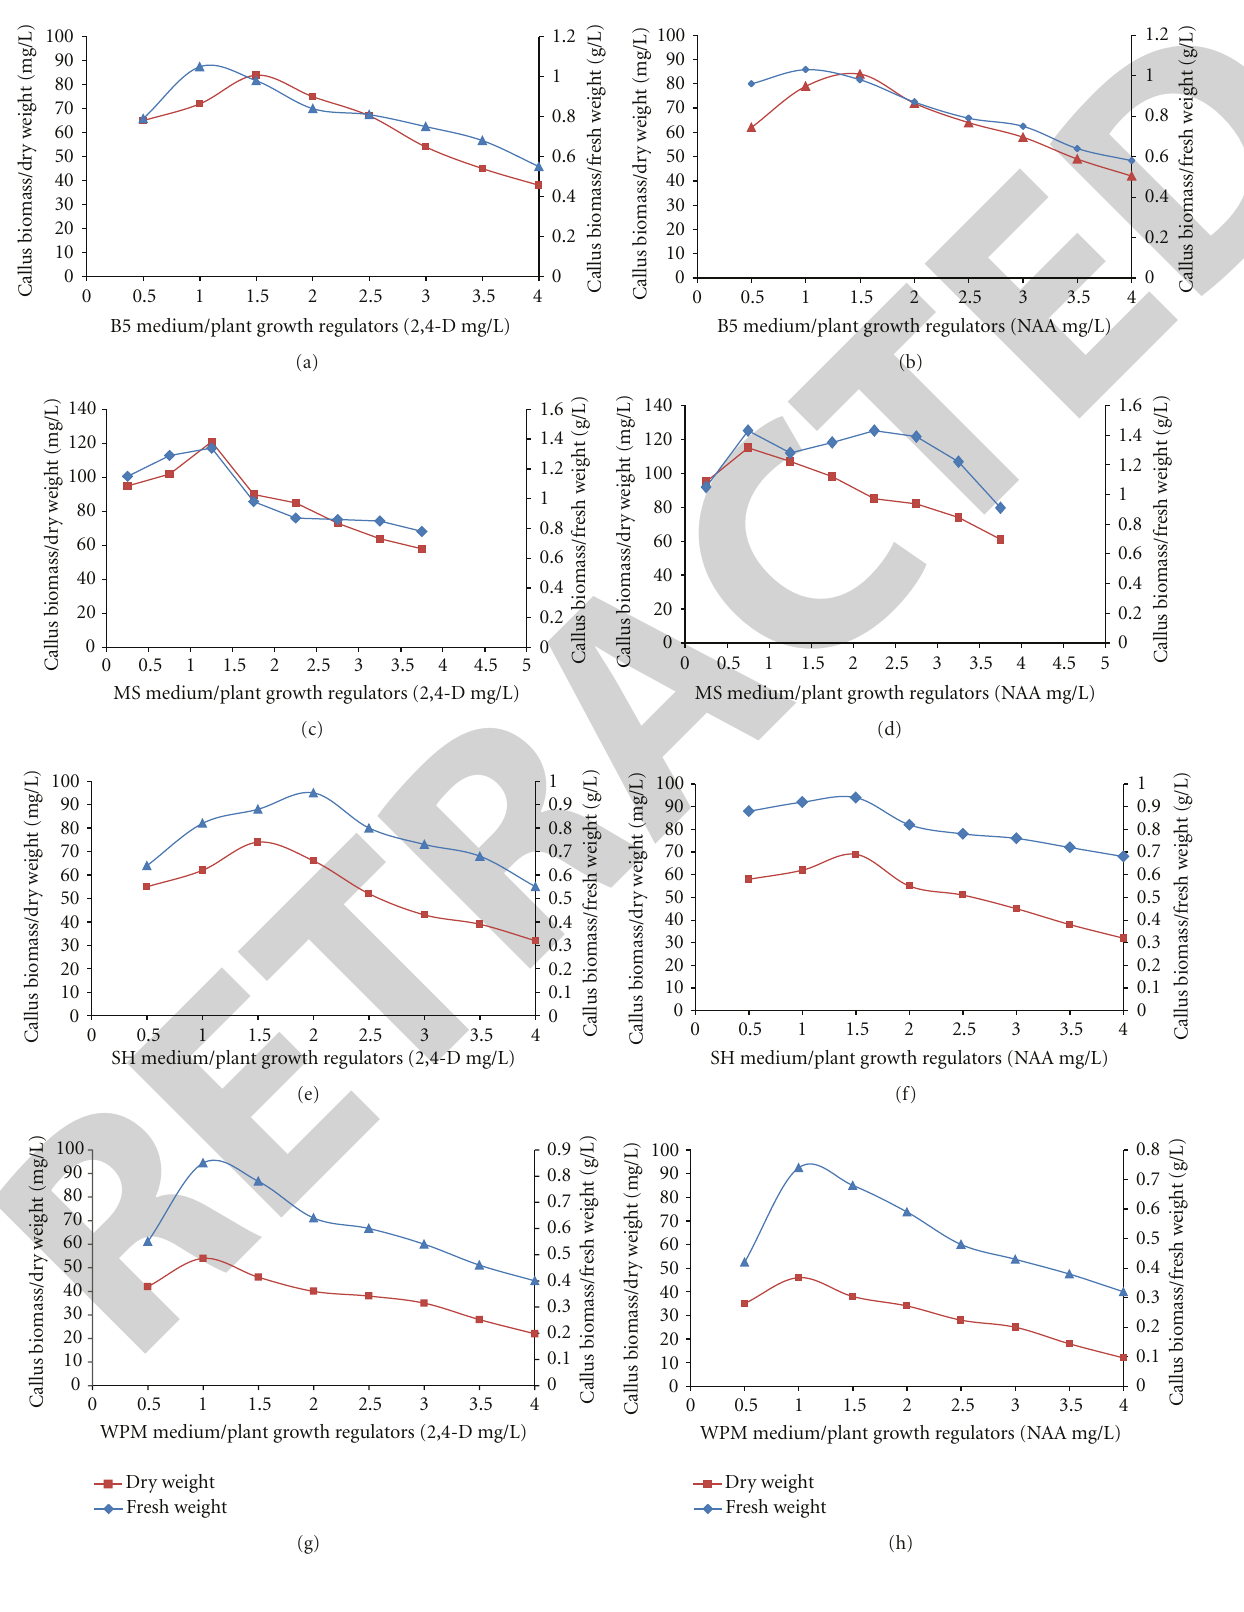
Figure 2: E ff ect of di ff erent media (B5, MS, SH, and WPM) supplemented with 2,4-D and NAA on induction of biomass (fresh and